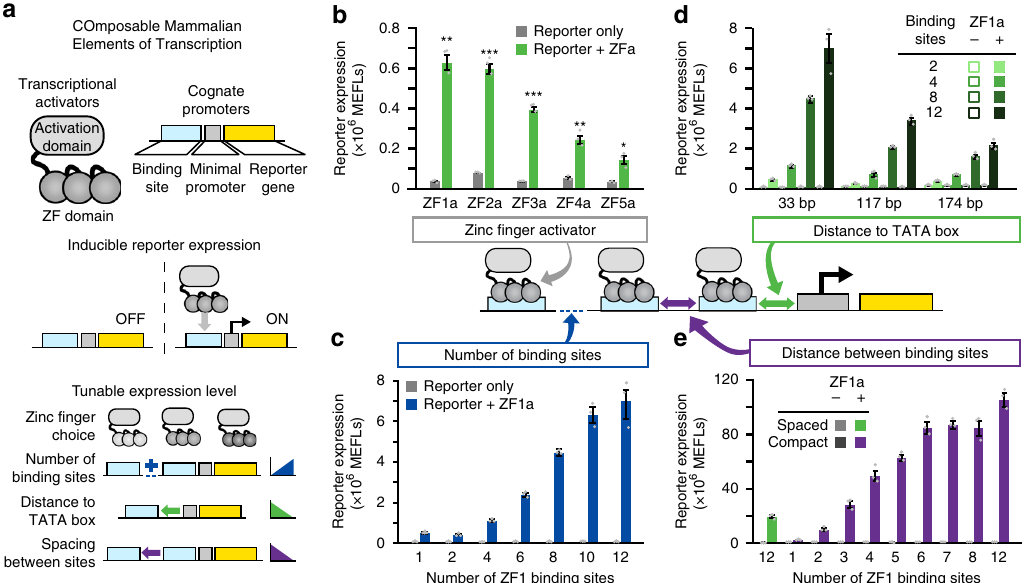
Fig. 1 Investigation of COMET promoter design rules. a The schematic shows the modular, tunable features of COMET TFs and promoters. b Five ZFa with different ZF domains all induced reporter expression (one-tailed Welch ’ s t -test: * p < 0.05, ** p < 0.01, *** p < 0.001). c Increasing the number of ZF binding sites increased the level of gene expression in the presence of ZFa (ANOVA p < 0.001) but not without ZFa (ANOVA p = 0.24). Reporter expression increased signi fi cantly from 6 to 8 and from 8 to 10 binding sites but not on either side of this range (Tukey ’ s HSD test with α = 0.05). d Moving the ZF binding site array farther upstream of the TATA box reduced reporter expression (two-factor ANOVA p < 0.001), and arrays with more binding sites showed more substantial decreases in reporter expression. e Compaction of ZFa binding sites enhanced ZFa-induced reporter expression, for an equivalent number of ZF binding sites (one-tailed Welch ’ s t -test, p = 0.002), and across compact promoters, ZFa-induced reporter expression increased with the number of binding sites (ANOVA p < 0.001). Reporter expression increased signi fi cantly from 2 to 3, 3 to 4, 5 to 6, and 8 to 12 binding sites (Tukey ’ s HSD test with α = 0.05). Experiments were conducted in biologic triplicate, and data were analyzed as described in Methods. Error bars represent the S.E.M. Source data are provided in the Source Data fi